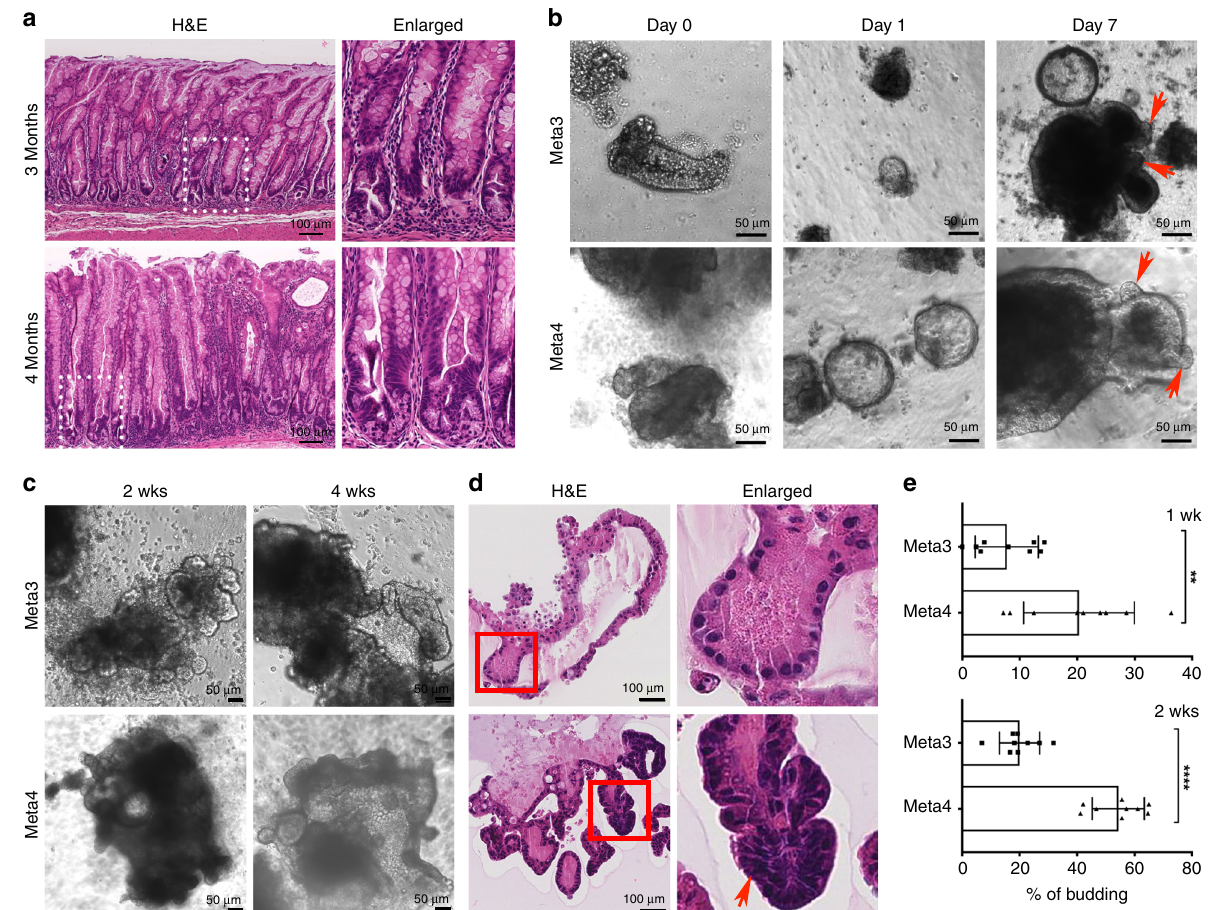
Fig. 1 Establishment and characterization of Meta3 and Meta4 organoid lines. a H&E stained slides show stomach mucosa used to isolate metaplastic or dysplastic glands only from the corpus area of Mist1-Kras mouse stomachs at 3 or 4 (Meta3 or Meta4) months after tamoxifen injection. Dotted boxes indicate enlarged area. Scale bars indicate 100 μ m. b Phase contrast images of Meta3 and Meta4 organoids captured 0, 1, and 7 days after plating in Matrigel. Red arrows indicate budding structures. Scale bars indicate 50 μ m. c Phase contrast images of Meta3 and Meta4 captured at 2 or 4 weeks in 3D culture. Scale bars indicate 50 μ m. d Paraf fi n embedded sections from Meta3 or Meta4 organoids at 4 weeks in 3D culture examined by H&E staining. Red boxes indicate enlarged area. Red arrow indicates a representative multilayered area of Meta4. Scale bars indicate 100 μ m. e Quantitation of the average budding rate in Meta3 and Meta4 at 1 or 2 weeks in 3D cultures. Source data are provided as a Source Data fi le. Data are presented as mean values with standard deviation ( n = 9). P -values were calculated using unpaired two-tailed t -test. ** P = 0.004; **** P <